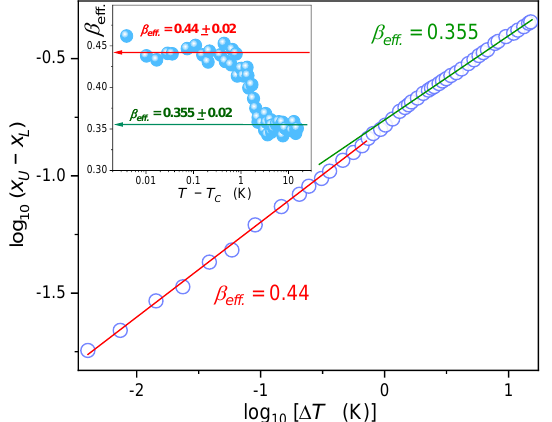
Figure 5. Order parameter related width of the Liquid-Liquid coexistence curve ( TP2 domain) analysis, based on data shown in Figure 1. The applied log-log scale facilitates the analysis via the ‘effective critical’ Equation (5). The inset is for the results of the derivative analysis based on Equation (6). Values of obtained order parameter exponent in subsequent temperature domains are given.